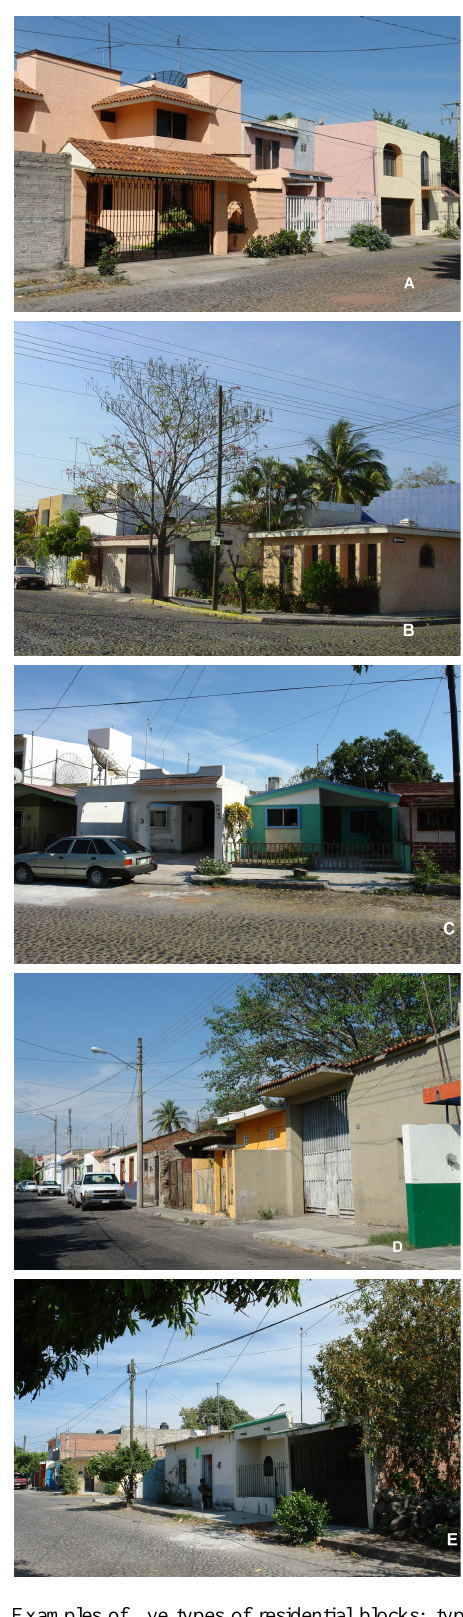
Fig. 4. Examples of five types of residential blocks: type 1 (A)